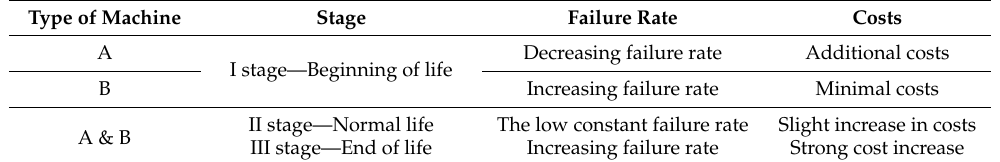
Table 1. Overview of failure rate and costs phenomenon in lifetime stages of different machine types. Type of Machine Stage Failure Rate Costs A Decreasing failure rate Additional costs I stage—Beginning of life Increasing failure rate The low constant failure rate Increasing failure